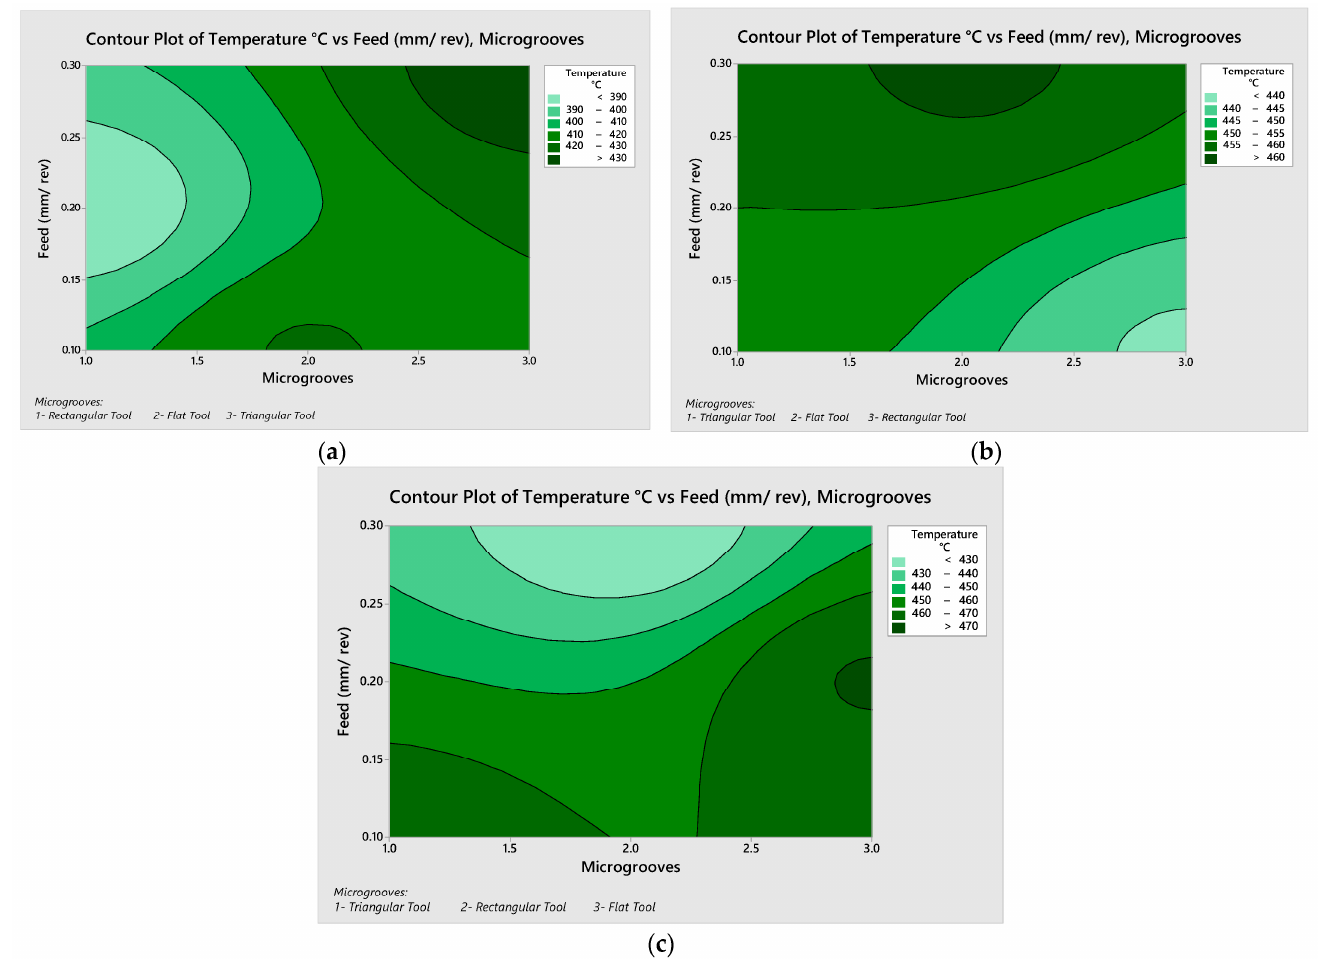
Figure 5. Contour plots for the cutting temperature ( a ) 75 m/min ( b ) 150 m/min and ( c ) 225